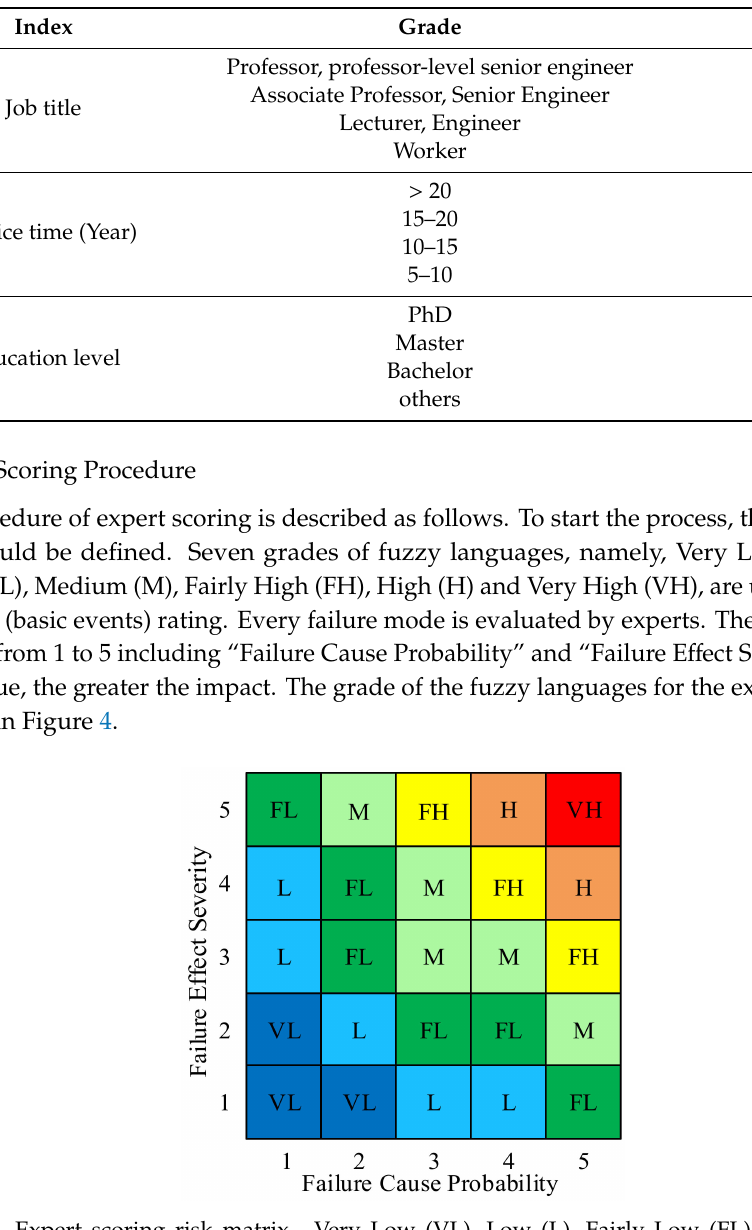
Figure 4. Expert scoring risk matrix. Very Low (VL), Low (L), Fairly Low (FL), Medium (M), Fairly High (FH), High (H) and Very High